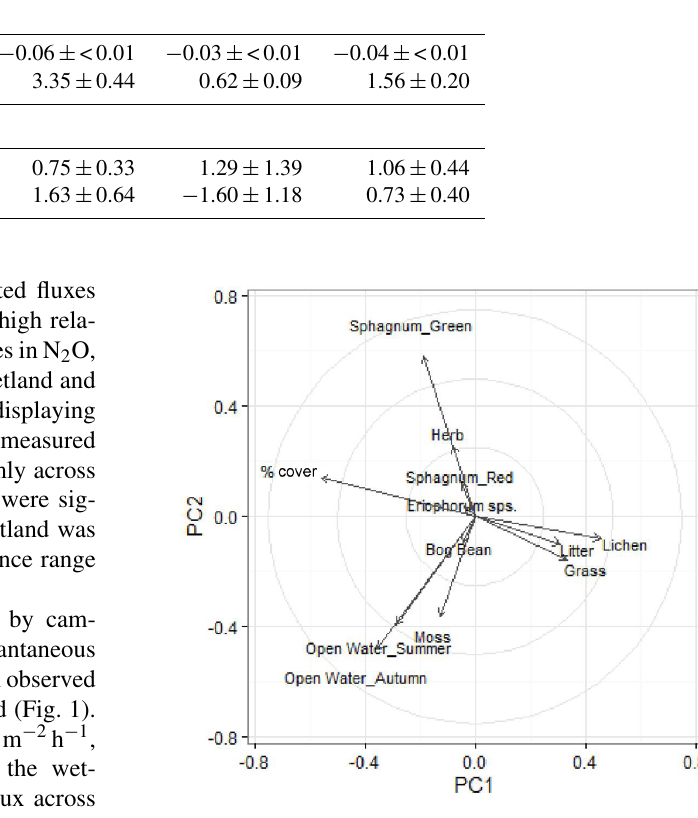
Figure 2. Loading values for principal components 1 and 2 of the chamber vegetation